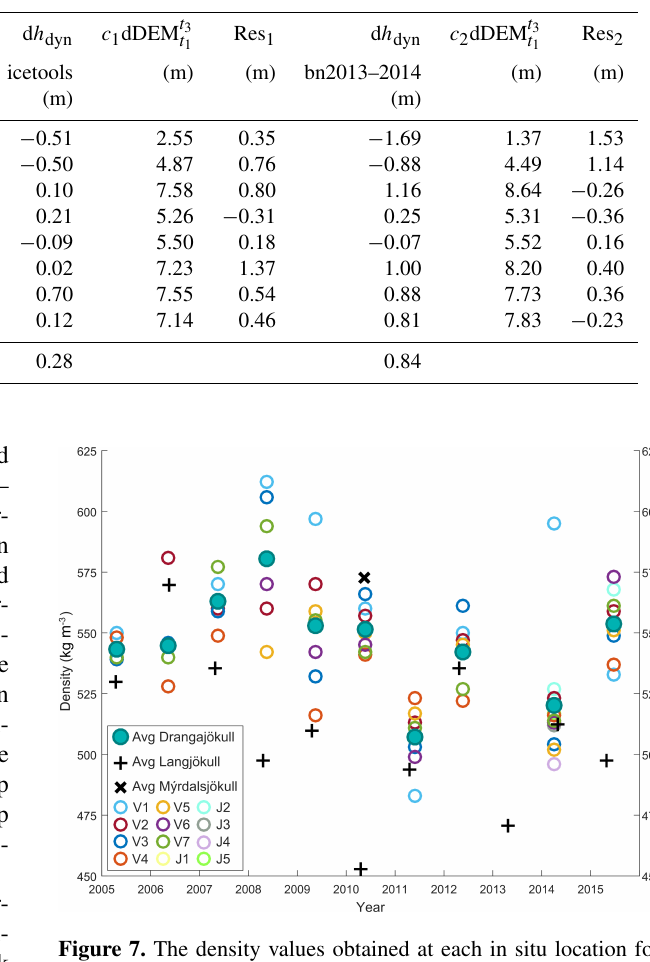
Table 4. Comparison of values of snow thickness, h snow insitu , measured in the field, and elevation difference obtained from Pléiades DEMs, h to make them comparable to the . The table lists all corrections applied pointwise to the Pléiades elevation differences dDEM t 3 t dDEM t 3 t 1 1 in situ measurements (see text for details). The table also compares two approaches carried out for correction of surface emergence and submergence velocities: (1) d h dyn icetools using a glacier ice flow model (Jarosch, 2008) and (2) d h dyn bn2013–2014 using records of mass balance (Sold et al., 2013). c 1 dDEM t 3 t and c 2 dDEM t 3 t show the corrected dDEM t 3 t , using the two different approaches, and Res 1 and Res 2 1 1 1 are the residuals between the glaciological and geodetic methods after applying the corrections.